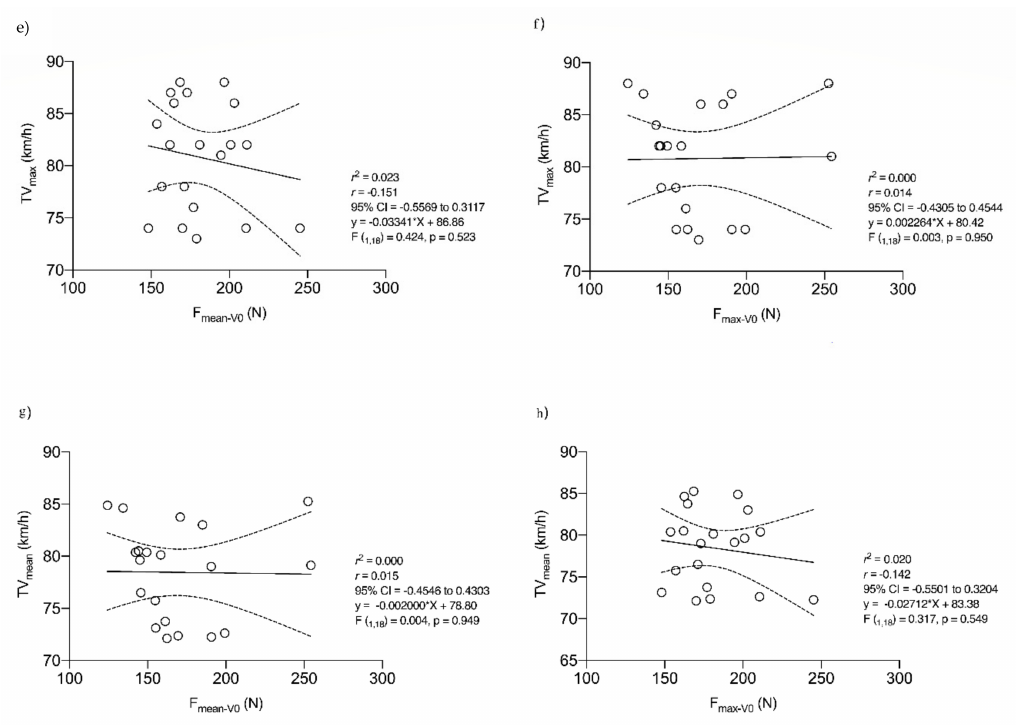
Figure 3. Linear regression between mean (TVmean) and maximum (TVmax) throwing velocity and value where the force–mean velocity profile curve intersects the velocity axis (Vmean-F0) and value where the force–maximum velocity profile curve intersects the velocity axis (Vmax-F0). ( a ) Linear regression between TVmax and Vmean-F0. ( b ) Linear regression between TVmax and Vmax-F0. ( c ) Linear regression between TVmean and Vmean-F0. ( d ) Linear regression TVmean and Vmax-F0. ( e ) Linear regression between TVmax and Fmean-V0. ( f ) Linear regression between TVmax and Fmax-V0. ( g ) Linear regression between TVmean and Fmean-V0. ( h ) Linear regression between TVmean and